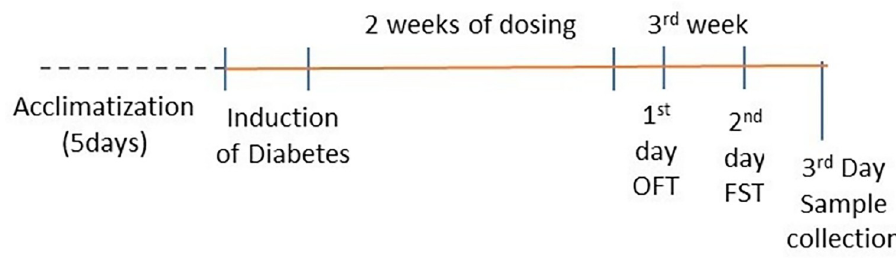
Fig 3. Schematic representation of diabetes induction, drug treatment and behavioral assessment. The days of behavioral tests are expressed along with the abbreviation of test. Abbreviations: OFT–Open Field Test, FST–Forced